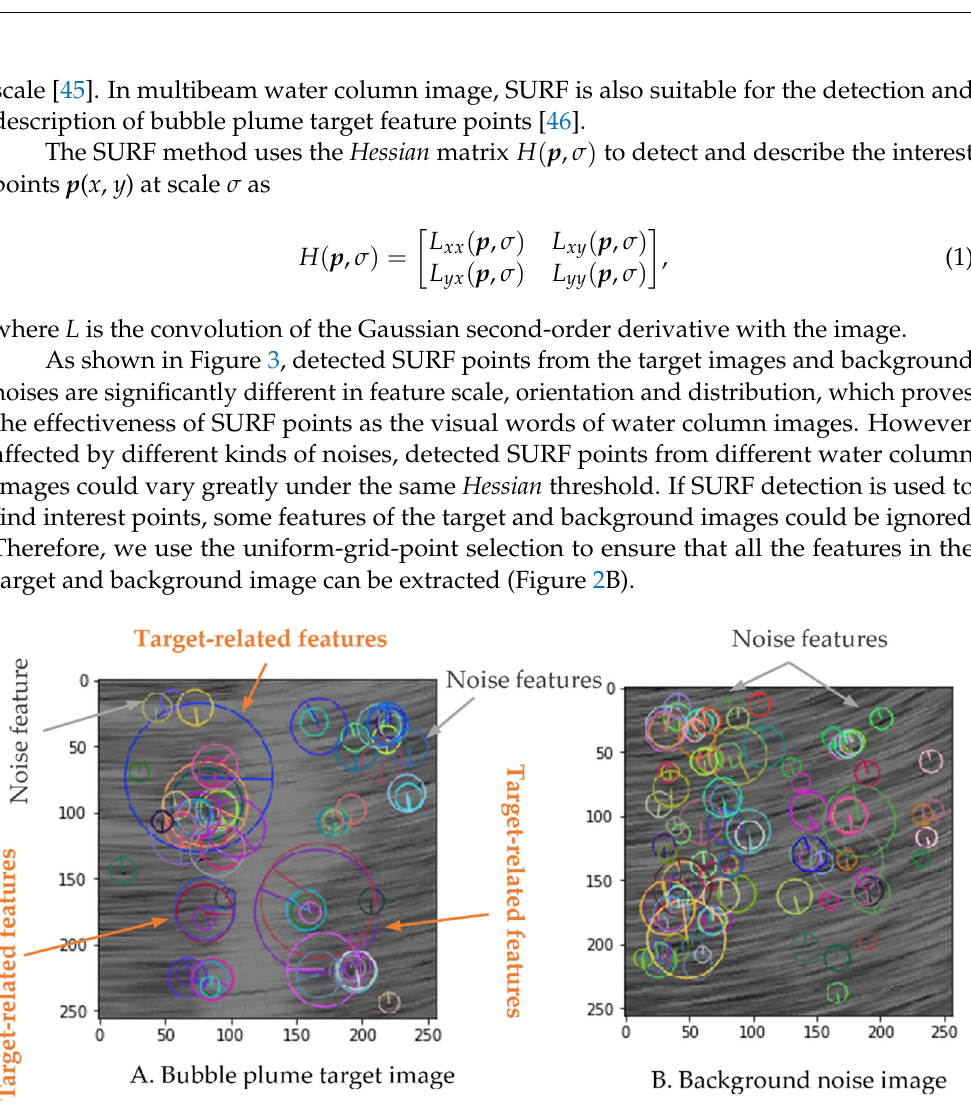
Figure 3. SURF differences between bubble plume target and background image in multibeam water column image ( Hessian threshold was set as 250). The radiuses of these circles indicate the scales of these detected points, and the lines in these circles mean the main directions of these features.